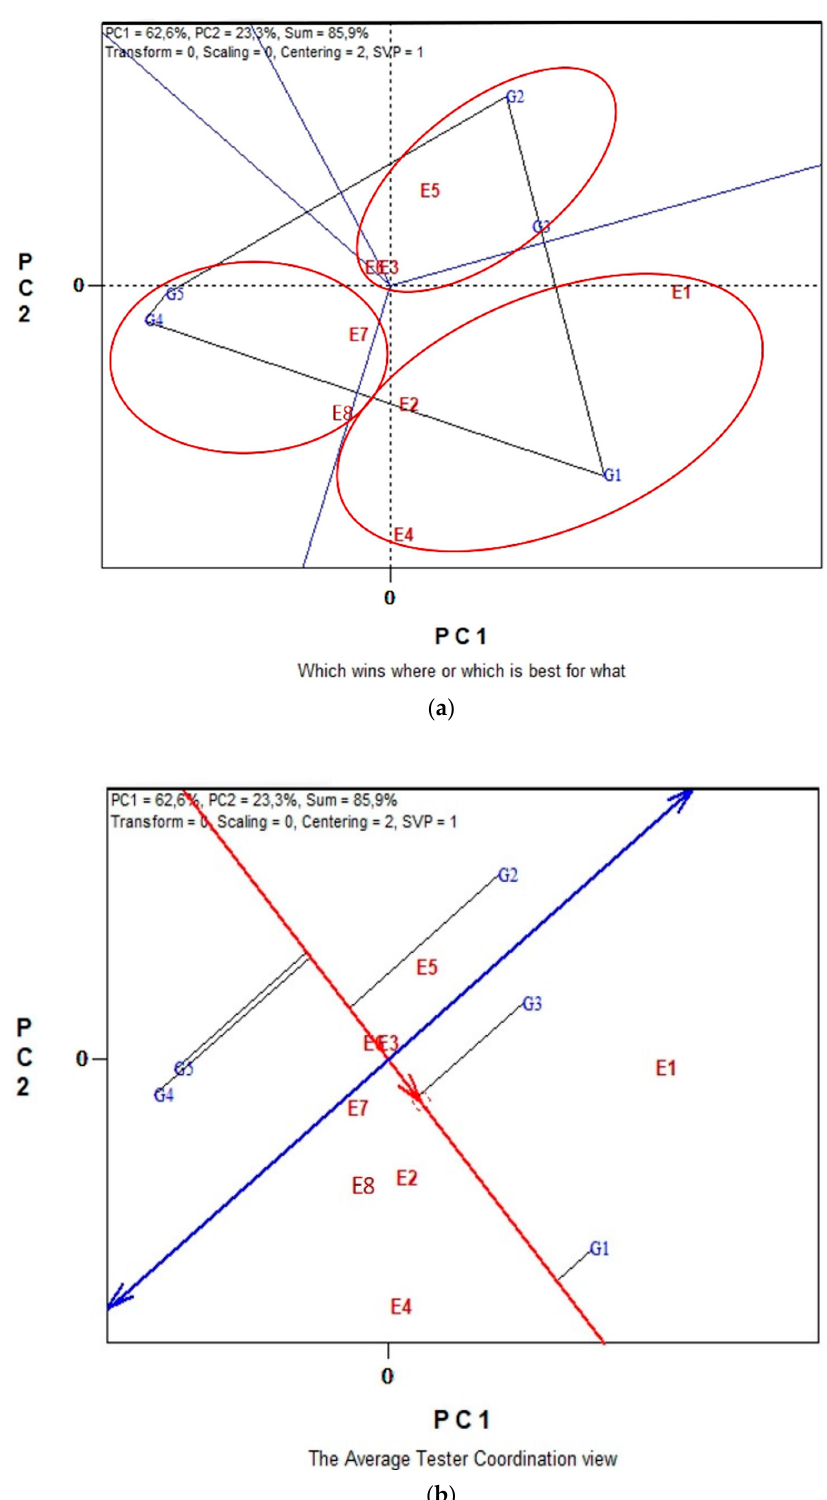
Figure 2. Biplot analysis in conventional farming: ( a ) “which-won-where or which is best for what” view of the GGE biplot based on seed yield of five lentil genotypes in eight environments. Environment 1 and Environment 2 coincide; ( b ) “discriminating power vs. representativeness” view of the GGE biplot based on yield of five lentil genotypes in eight environments. Environment 3 and Environment 4